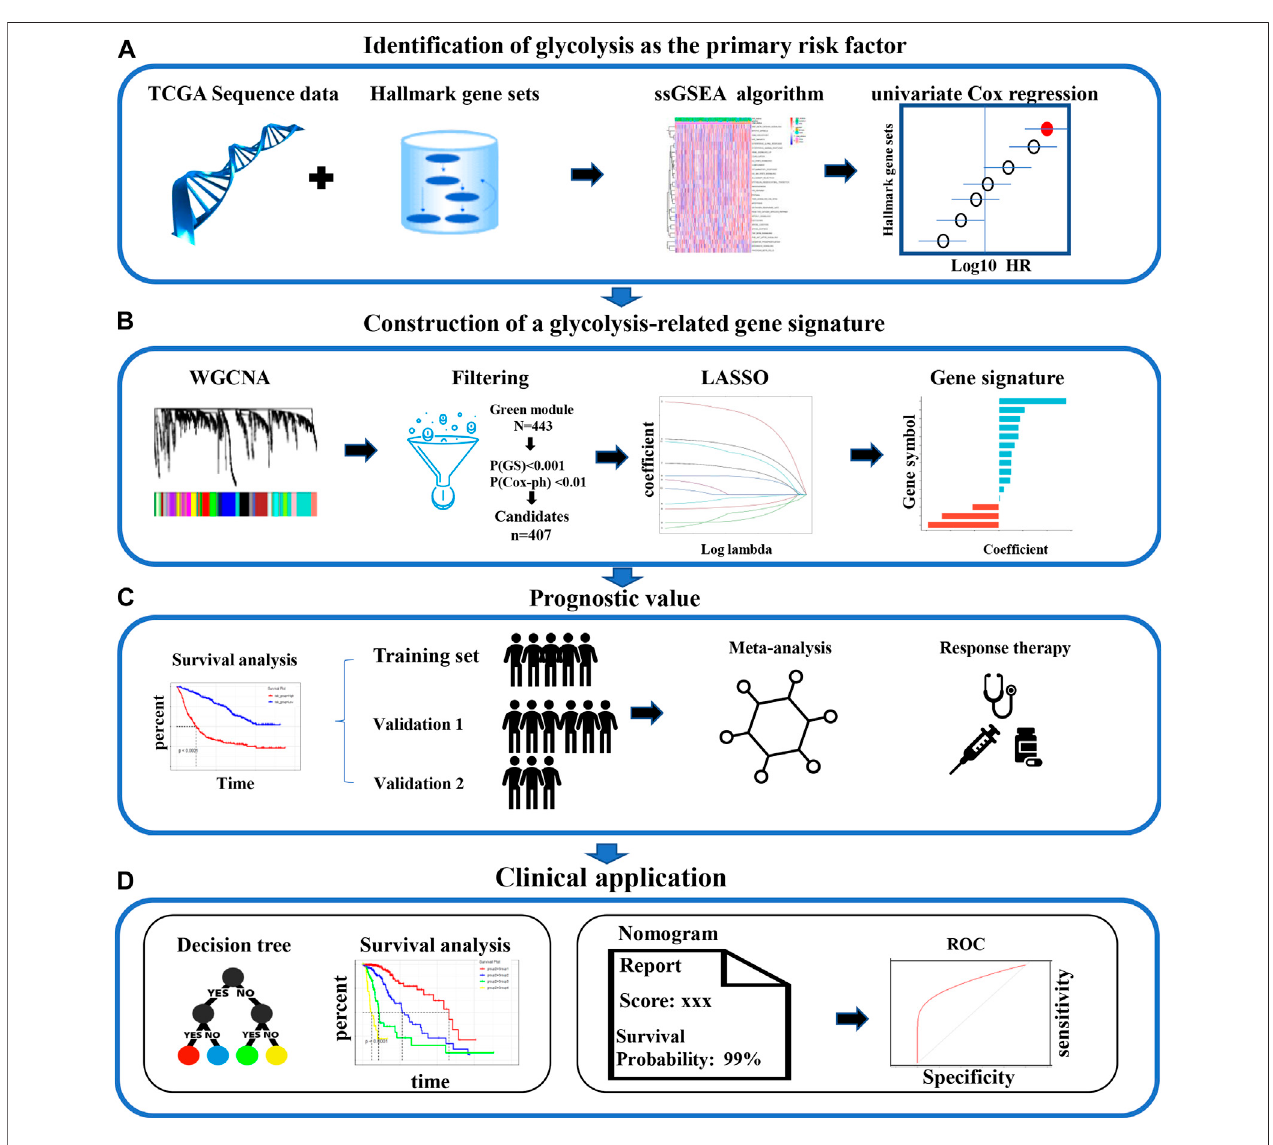
FIGURE 1 | The analysis the study work fl ow. (A) Among various hallmarks of cancer, we identi fi ed glycolysis as the primary risk factor for OS in patients with LGG (B) A robust glycolysis-related gene signature for patients with LGG was constructed using various bioinformatic methods. (C) The validation of the gene signature ’ s prognostic value in the CGGA and Rembrandt cohorts (D) Clinical signi fi cance. LGG: low-grade glioma; WGCNA, weighted gene co-expression network analysis; LASSO, least absolute shrinkage and selection operator; ROC, receiver operating characteristic; OS: overall survival.